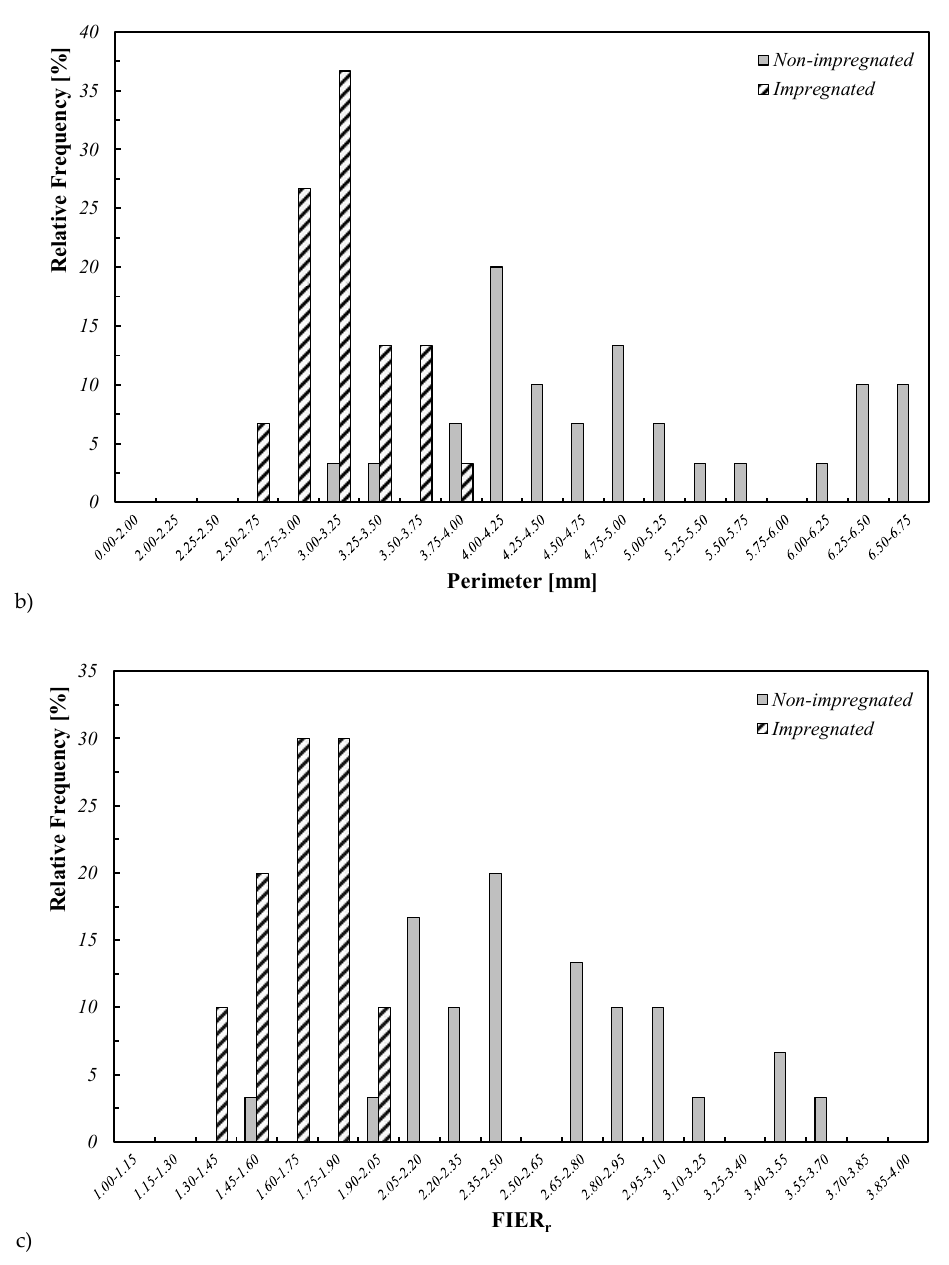
Figure 8. Frequency distribution for non-impregnated and impregnated yarns of the parameters: ( a ) area; ( b ) perimeter; ( c ) fiber intrinsic efficiency ratio (FIER r ).